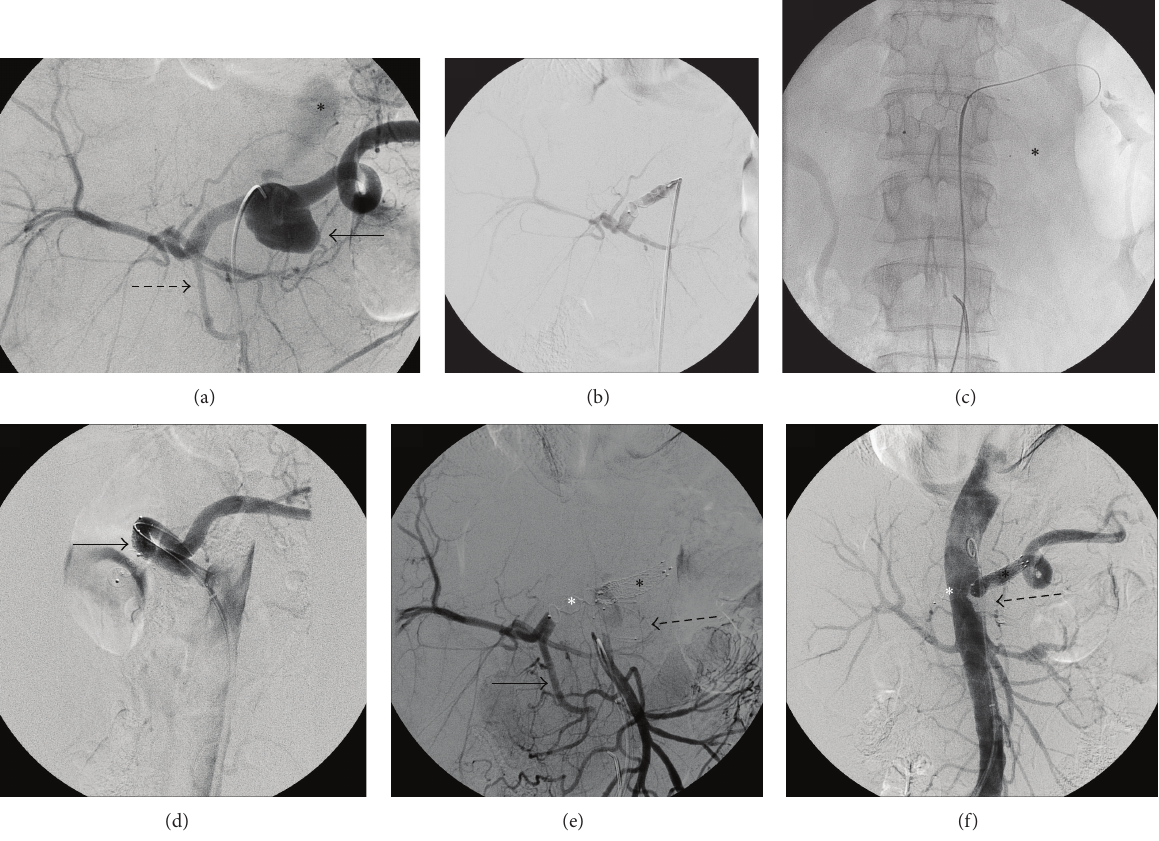
Figure 2: Diagnostic and procedural angiography. (a) Contrast injection from the celiac trunk confirming CT scan report: aneurysm of the celiac trunk (black arrow), cranial dissection, and consequent pseudoaneurysm (asterix) presenting with delayed enhancement and ectatic pancreaticoduodenal arcade (dashed black arrow); (b) release of a 12mm vascular plug in the proximal third of the common hepatic artery; ((c)-(d)) positioning of a microcatheter (asterix) inside the aneurysm sac and of a guidewire in the splenic artery for the following release of a 12 × 80 mm covered stentgraft (black arrow); (e) contrast injection from the superior mesenteric artery showing the pancreaticoduodenal arcade (solid black arrow) supporting liver vascularization after occlusion of the hepatic artery with a vascular plug (white asterix), stent in the splenic artery (black asterix), and microcatheter inside the aneurysm sac (dashed black arrow); (f) aortography showing the complete exclusion of the aneurysm sac fulfilled with Onyx (dashed black arrow), patency of the covered stent positioned in the splenic artery (black asterix), and occlusion of the hepatic artery with a vascular plug (white asterix).